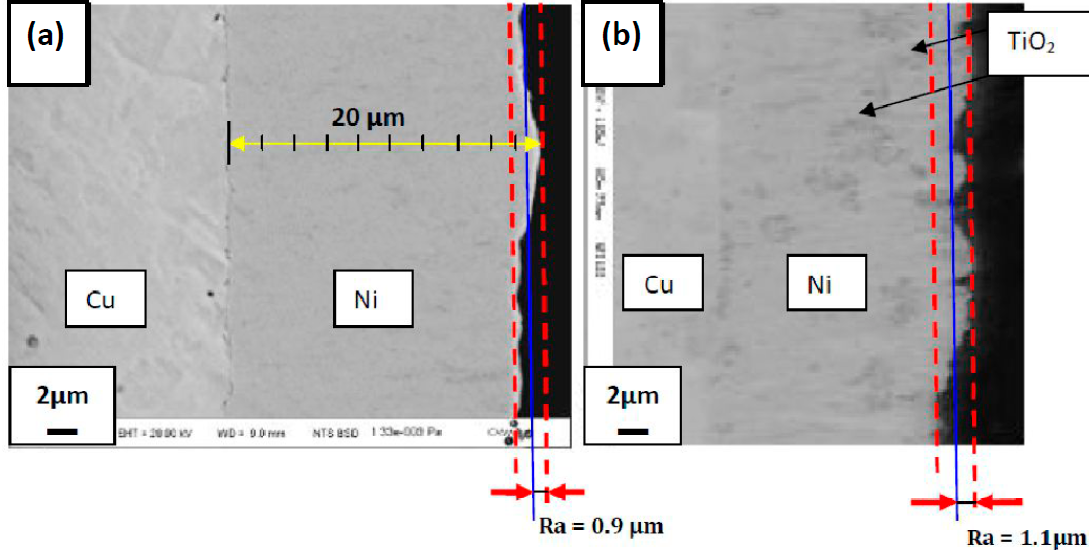
Figure 4. SEM observations of the electrodeposited Ni on Cu ( a ) without and ( b ) with the addition of 5g/L of TiO 2 .